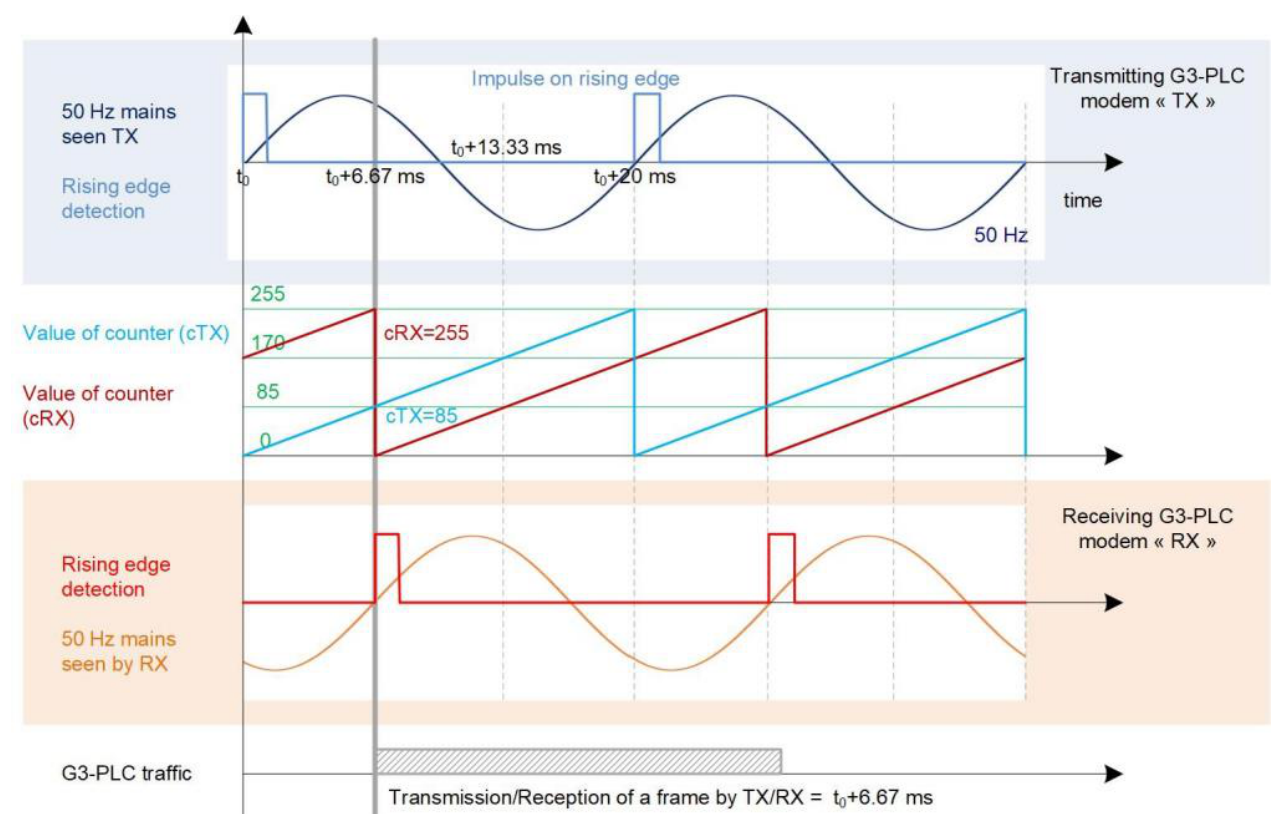
Figure 5. G3-PLC phase detection